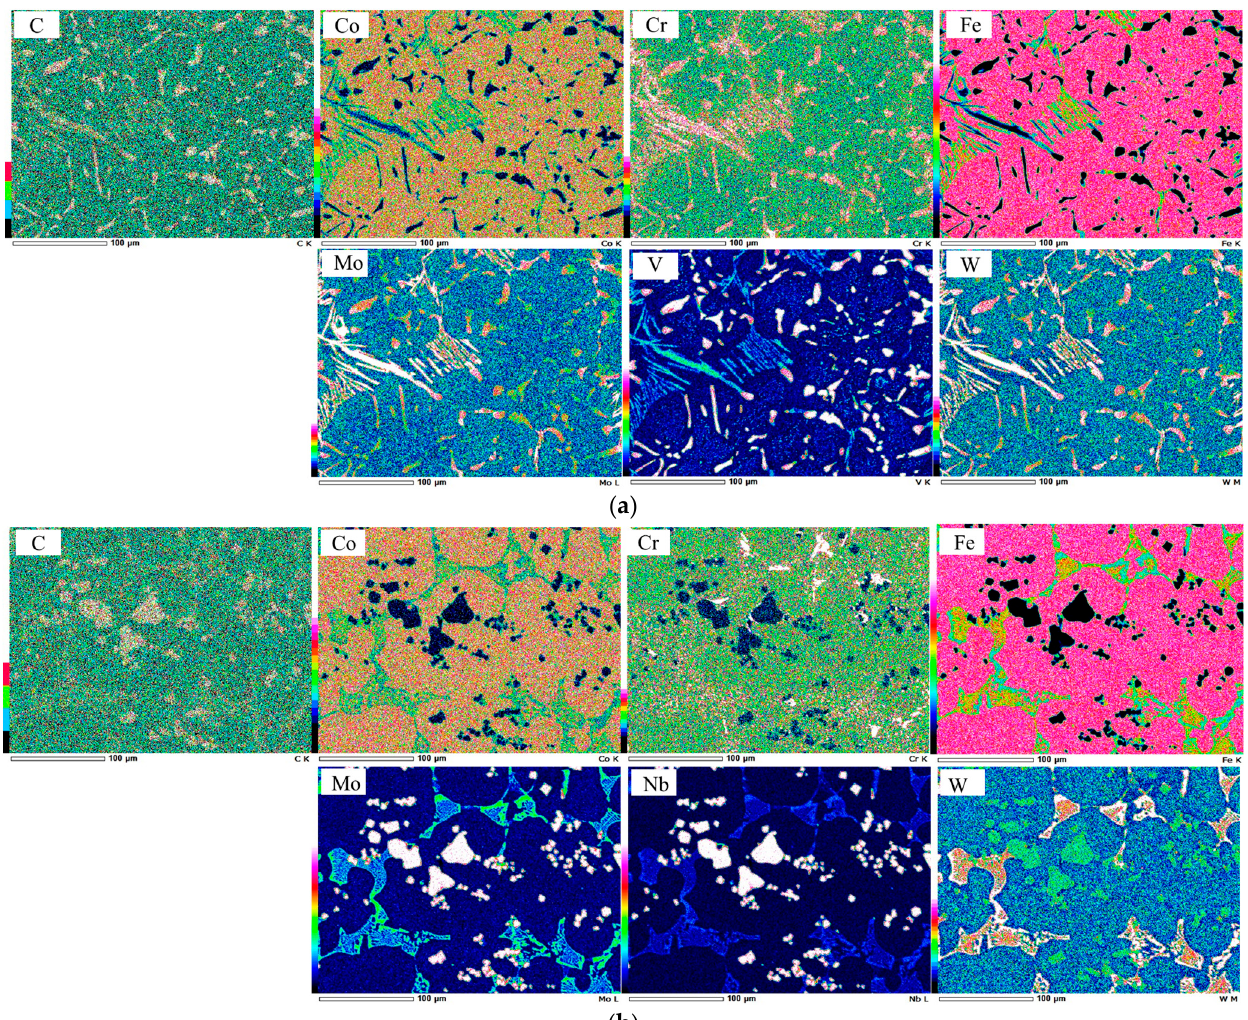
Figure 6. Elemental distribution of each transition metal on the microstructure. ( a ) 2C-5V alloy and ( b ) 2C-5Nb